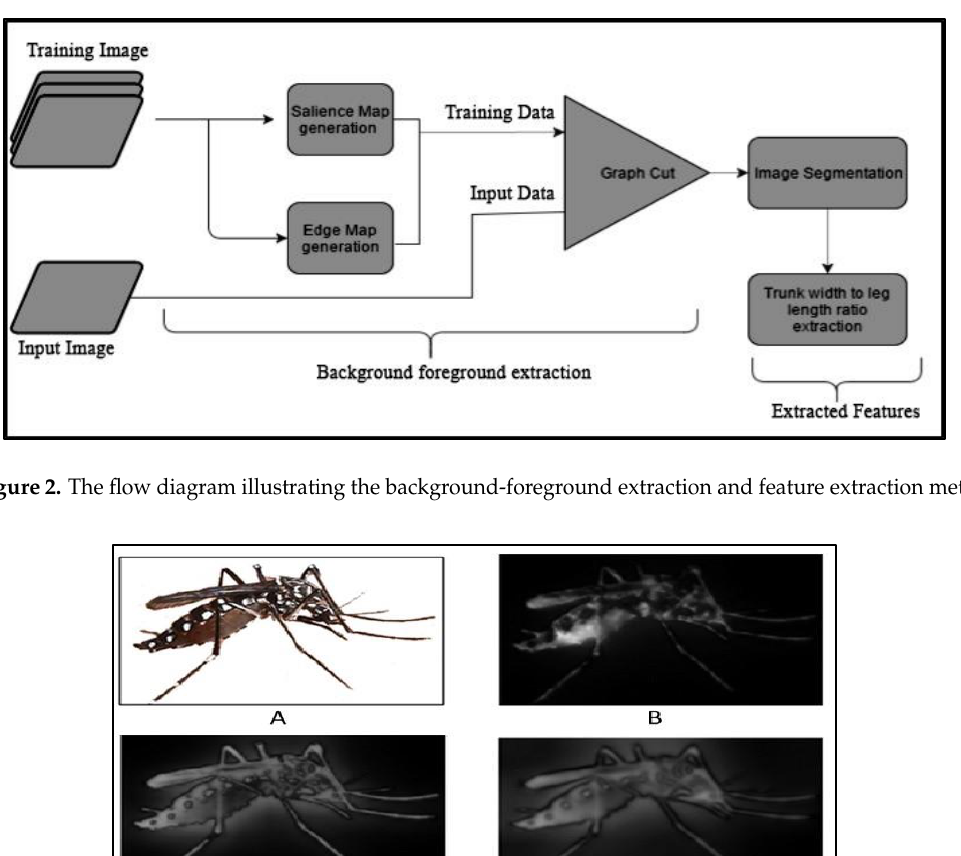
Figure 2. The flow diagram illustrating the background-foreground extraction and feature extraction methods.